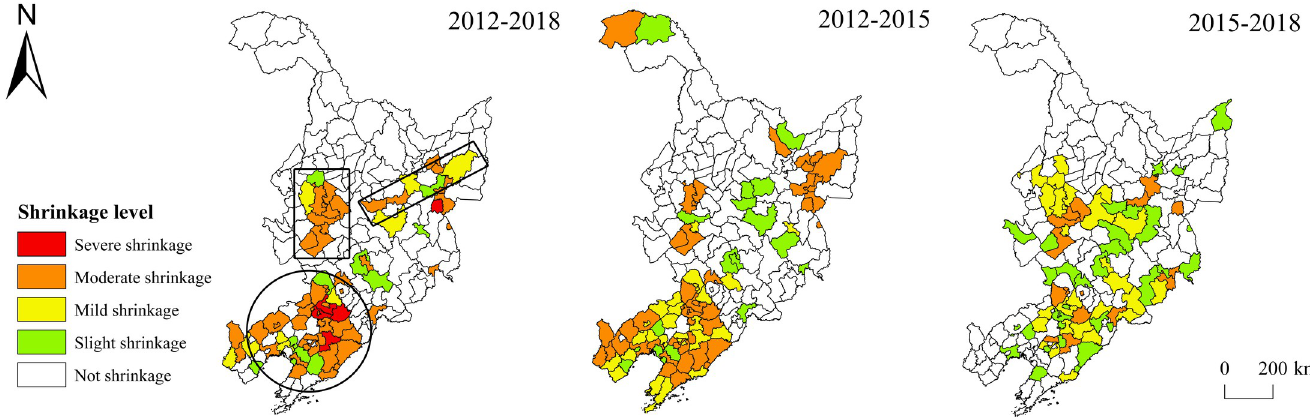
Fig 2. Spatial difference of comprehensive shrinkage of the three northeastern provinces. Note: The basic map came from a public map from the standard map service website of the Ministry of Natural Resources of China. The drawing approval number is GS (2016)1593.